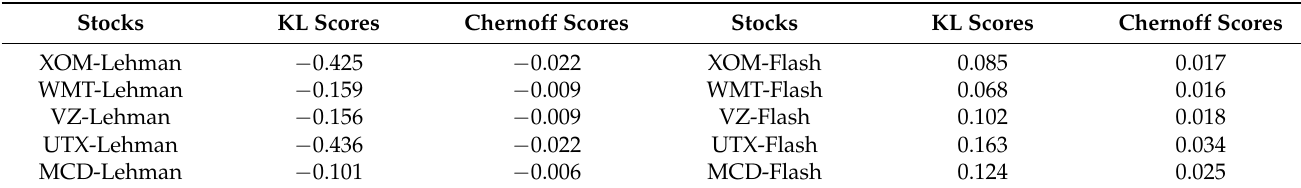
Table 15. Discriminant scores for Lehman Brothers collapse and flash crash event.